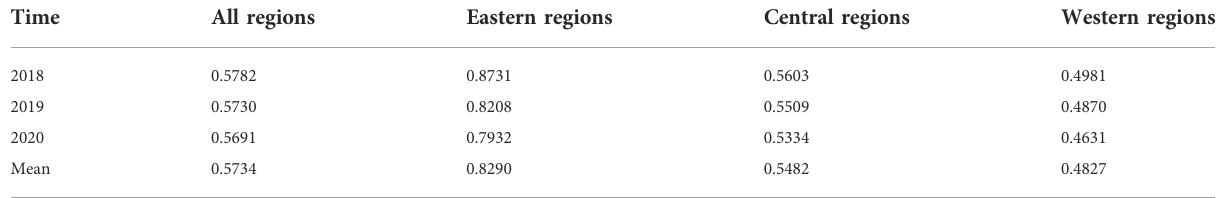
TABLE 2 Measurement results of urban agricultural carbon